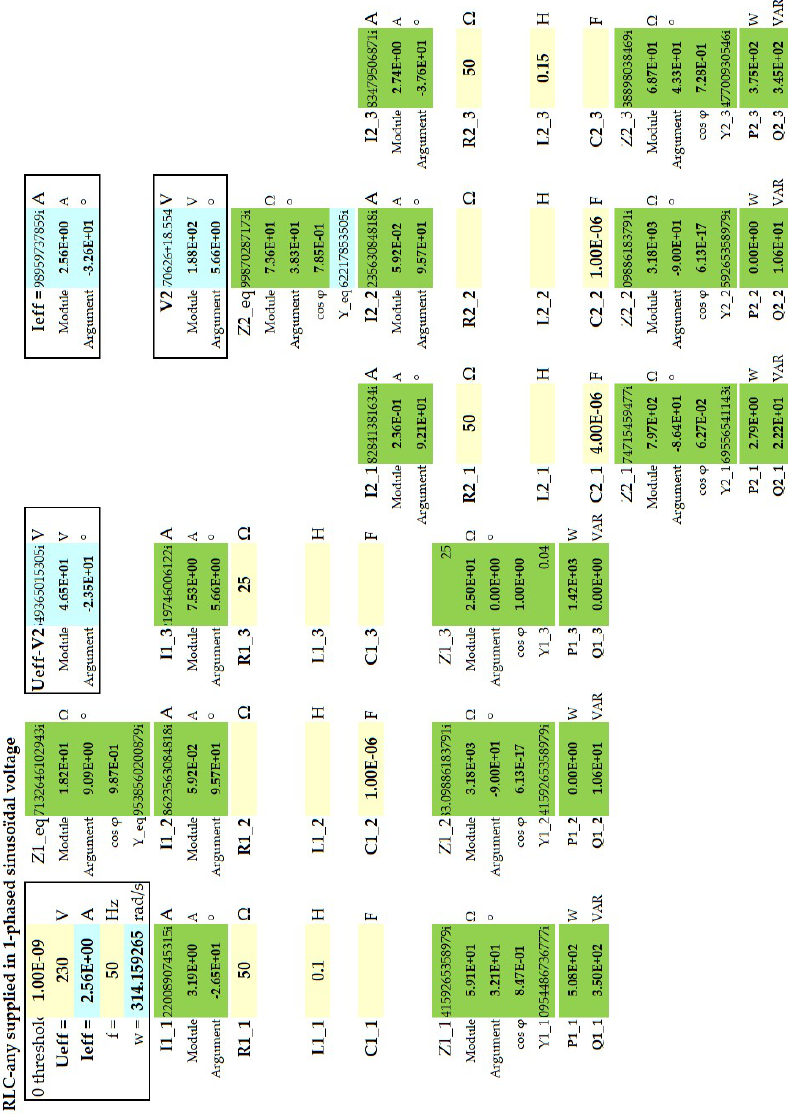
Figure 8. Results obtained with the 3 parallel RLC branches associated in series with 3 other parallel RLC branches’ circuit calculating sheet, on the particular case proposed in Figure